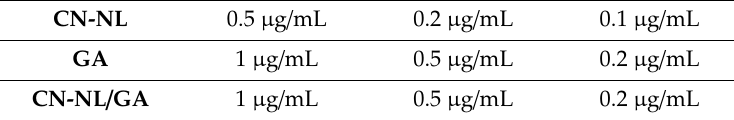
Table 2. Concentrations of compounds tested with